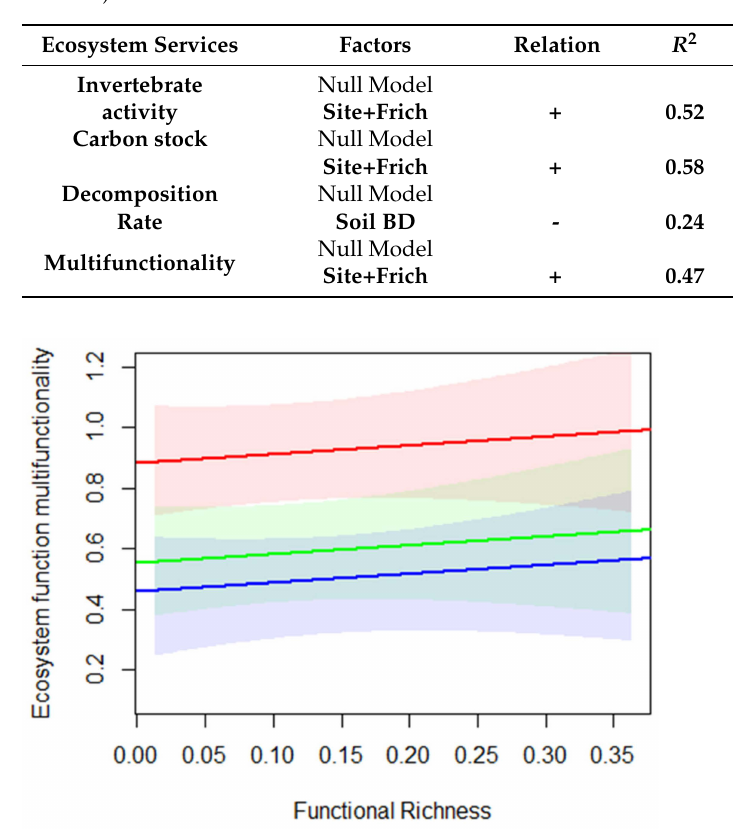
Table 3. Summary of the best-fitted models analysing ecosystem services in response to functional structure (composition and diversity) and soil factors. AICc = Akaike information criterion for small samples; ∆ AICc = difference between the AICc of a null model and the best model ( ∆ AIC < 2 in all cases).